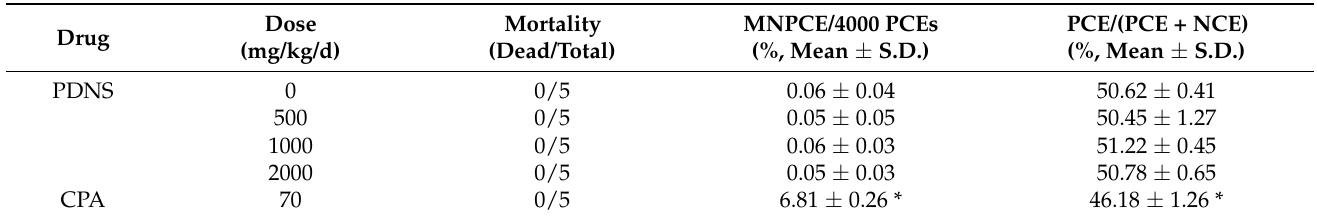
Table 9. Results of the micronucleus test in ICR mice exposed to oral treatment of powder of dried noni seeds